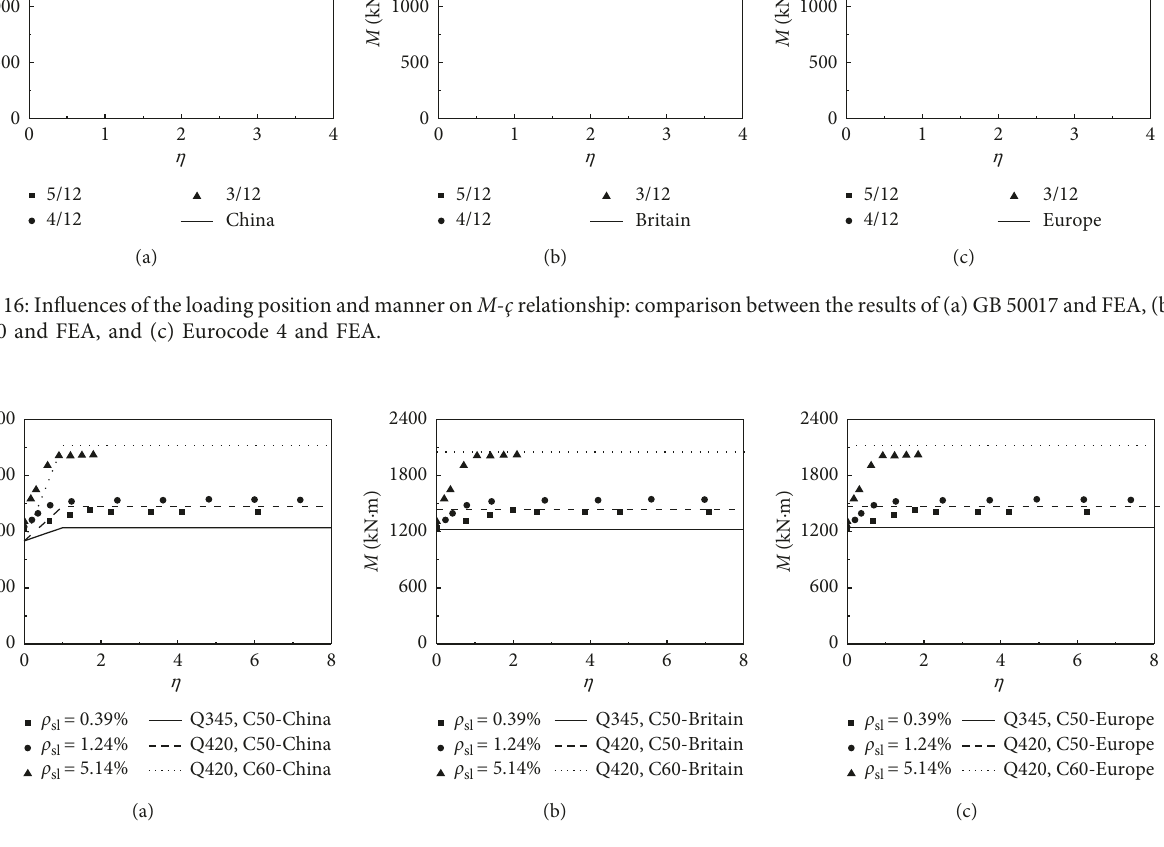
Figure 17: Influence of the longitudinal reinforcement ratio on M - ç relationship: comparison between the results of (a) GB 50017 and FEA, (b) BS 5950 and FEA, and (c) Eurocode 4 and